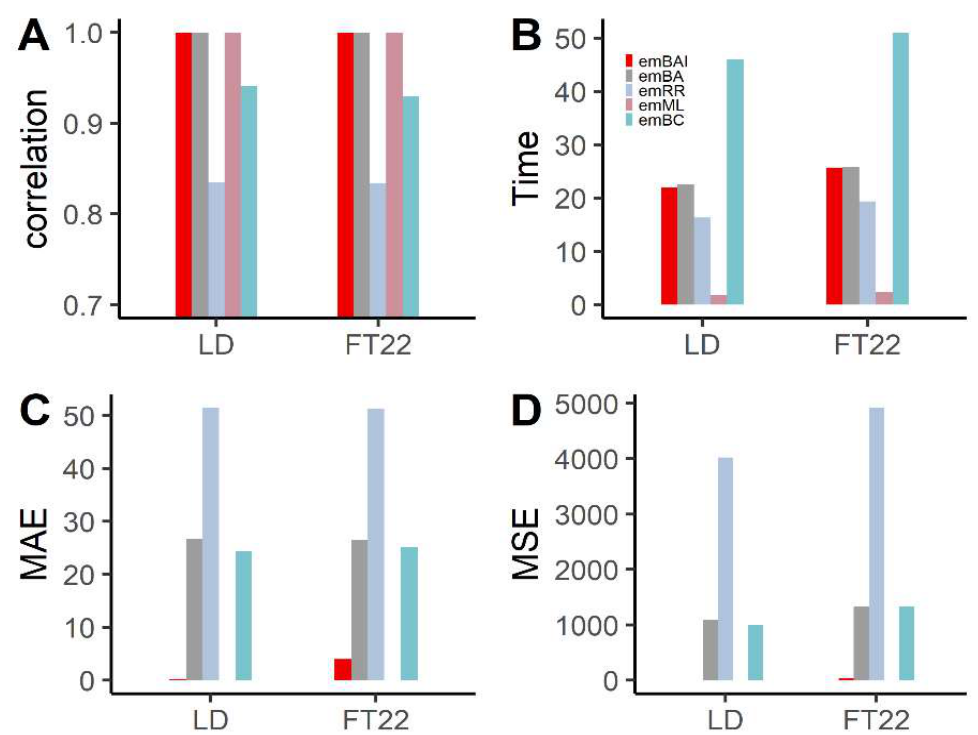
Figure 3. The correlation ( A ), computing time ( B ), MAE ( C ) and MSE ( D ) of Arabidopsis natural population analyses using emBAI, emBA, emRR, emML and emBC.